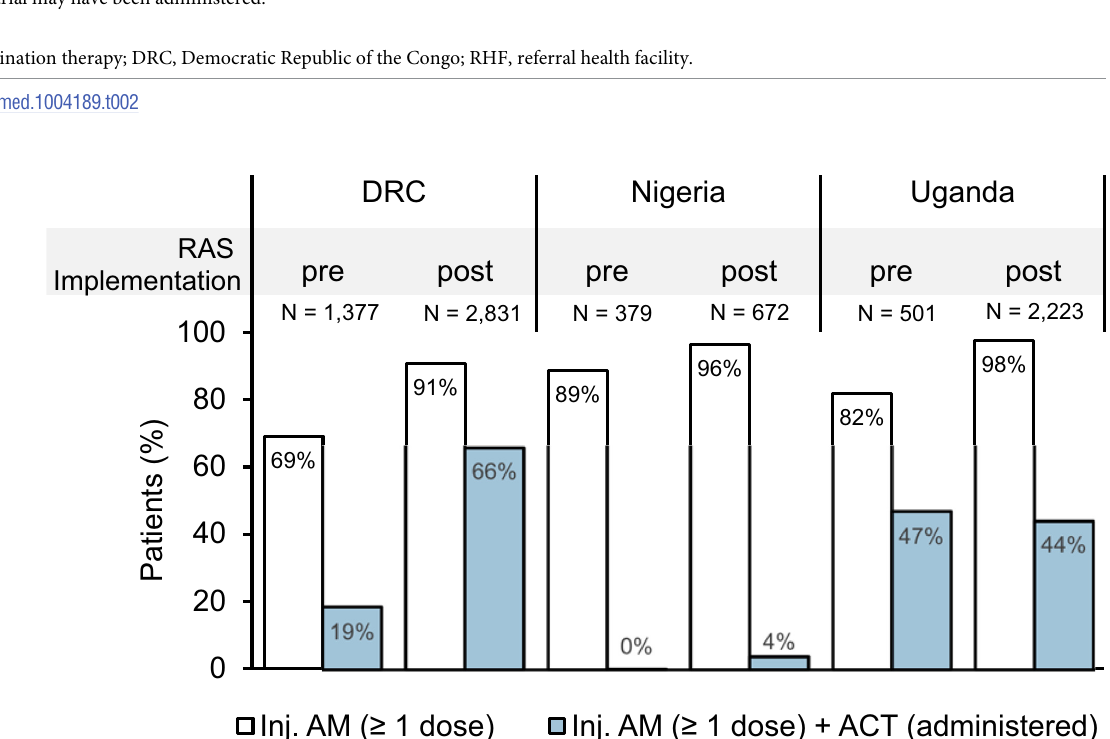
Number and column % of children receiving injectable and oral antimalarial treatment, by country and enrolment location. 1 More than 1 type of antimalarial may have been administered. 2 Appropriate medication.